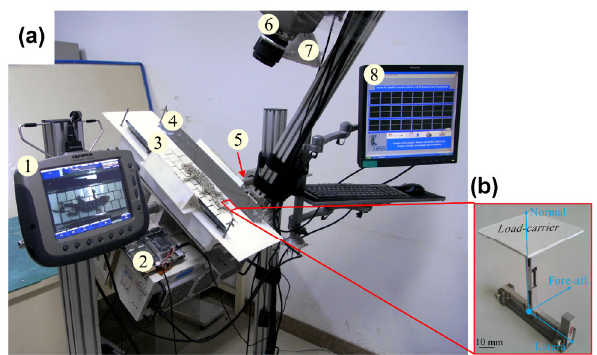
Fig. 1 Three-dimensional reaction force measuring and behavior observing system. (a) The system consists of a force-measuring array (FMA) and high-speed camera. 1, the control panel of high- speed camera; 2, synchronizer trigger; 3, an aisle of FMA; 4, mirrors; 5, rotating axis; 6, high-speed camera; 7, cold light illuminator; and 8, the control panel of FMA. The FMA can be rotated from horizontal to up-side-down to imitate different inclines. When a gecko moves through an aisle of the FMA, the dorsal view and two side-views in mirrors of locomotive behaviours were recorded by a high-speed camera located perpendicular to the FMA at 500